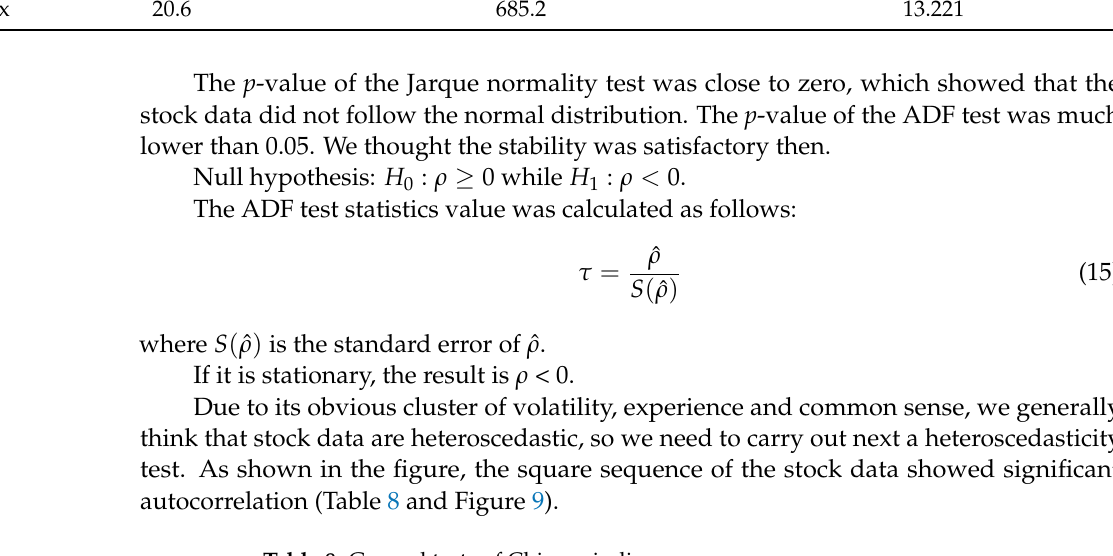
Table 8. General tests of Chinese indices.